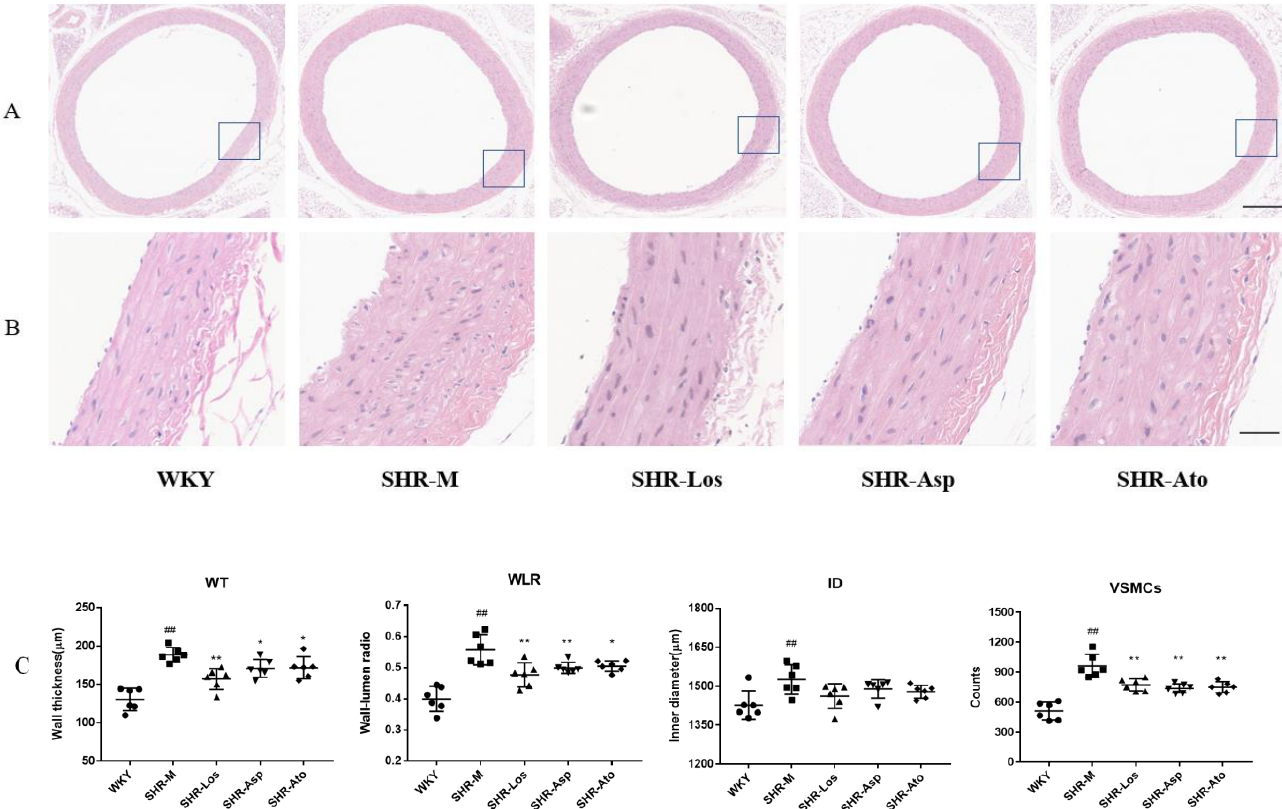
Figure 1. The histological morphological changes in thoracic aorta in each group (22 weeks rats). ( A ) H&E stain in cross section of thoracic aortas. (scale bar = 300 μm); ( B ) magnified images of ( A ) (scale bar = 50 μm); ( C ) wall thickness (WT), wall-to-lumen ratio (WLR), inner diameter (ID) and number of VSMCs (VSMC) in tunica media, respectively. The data are presented as the mean ± SD. n = 6, # p < 0.05, ## p < 0.01 vs. WKY; * p < 0.05, ** p < 0.01 vs. SHR-M.